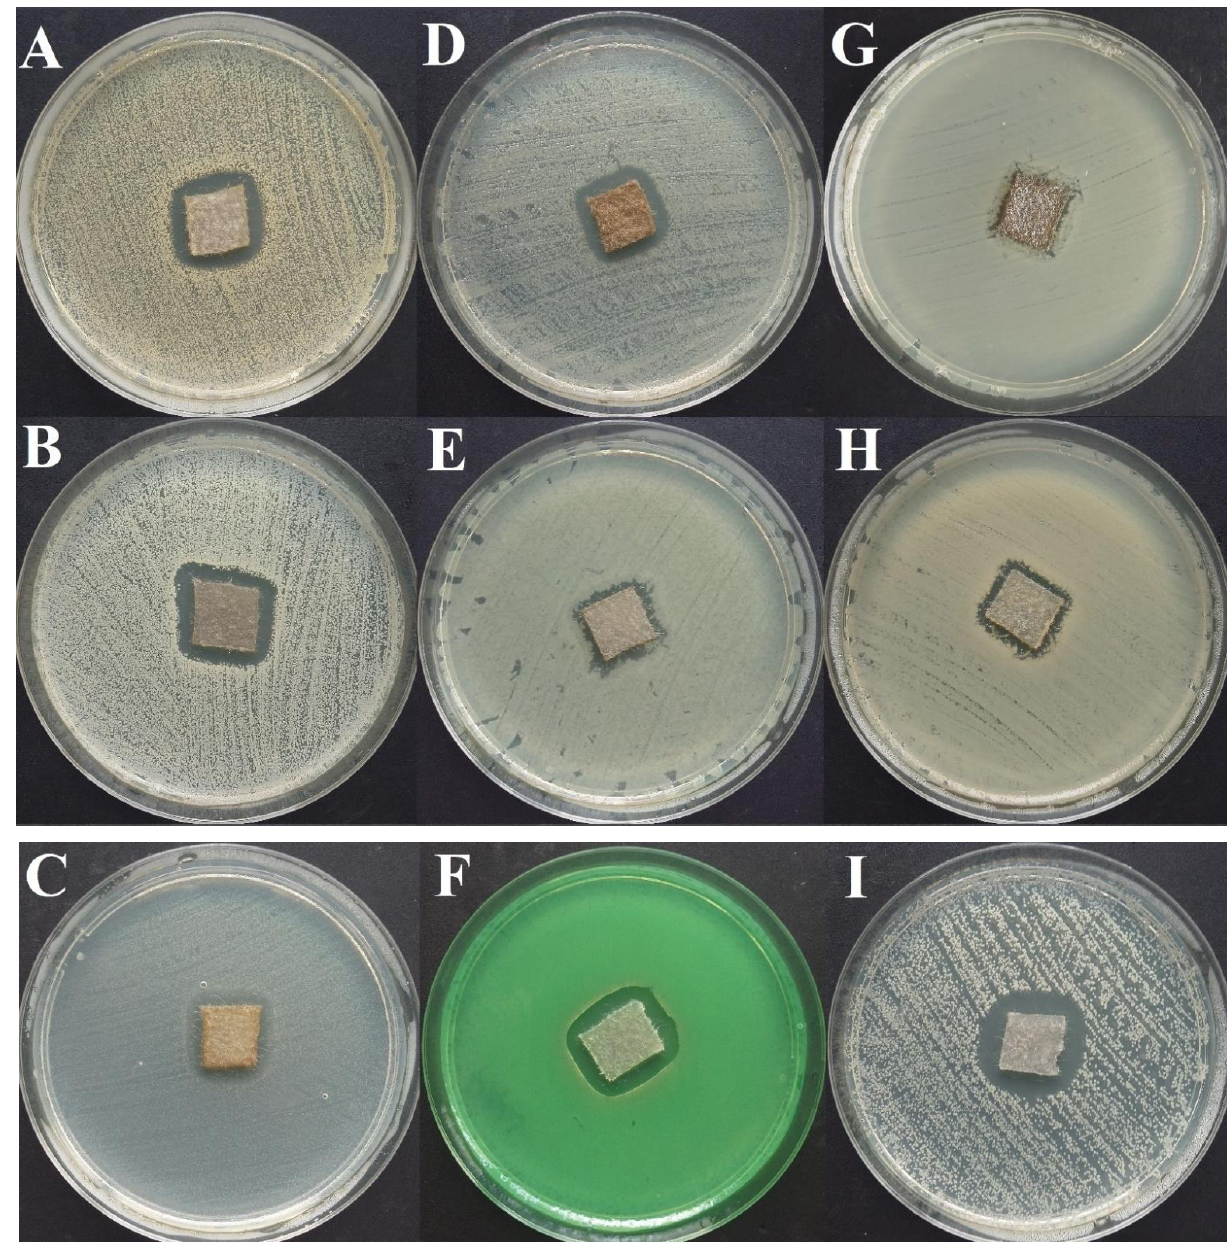
Figure 15. Growth inhibition zones in the modified disc-diffusion method. Aquacel ® Ag silver dressing was used, surface